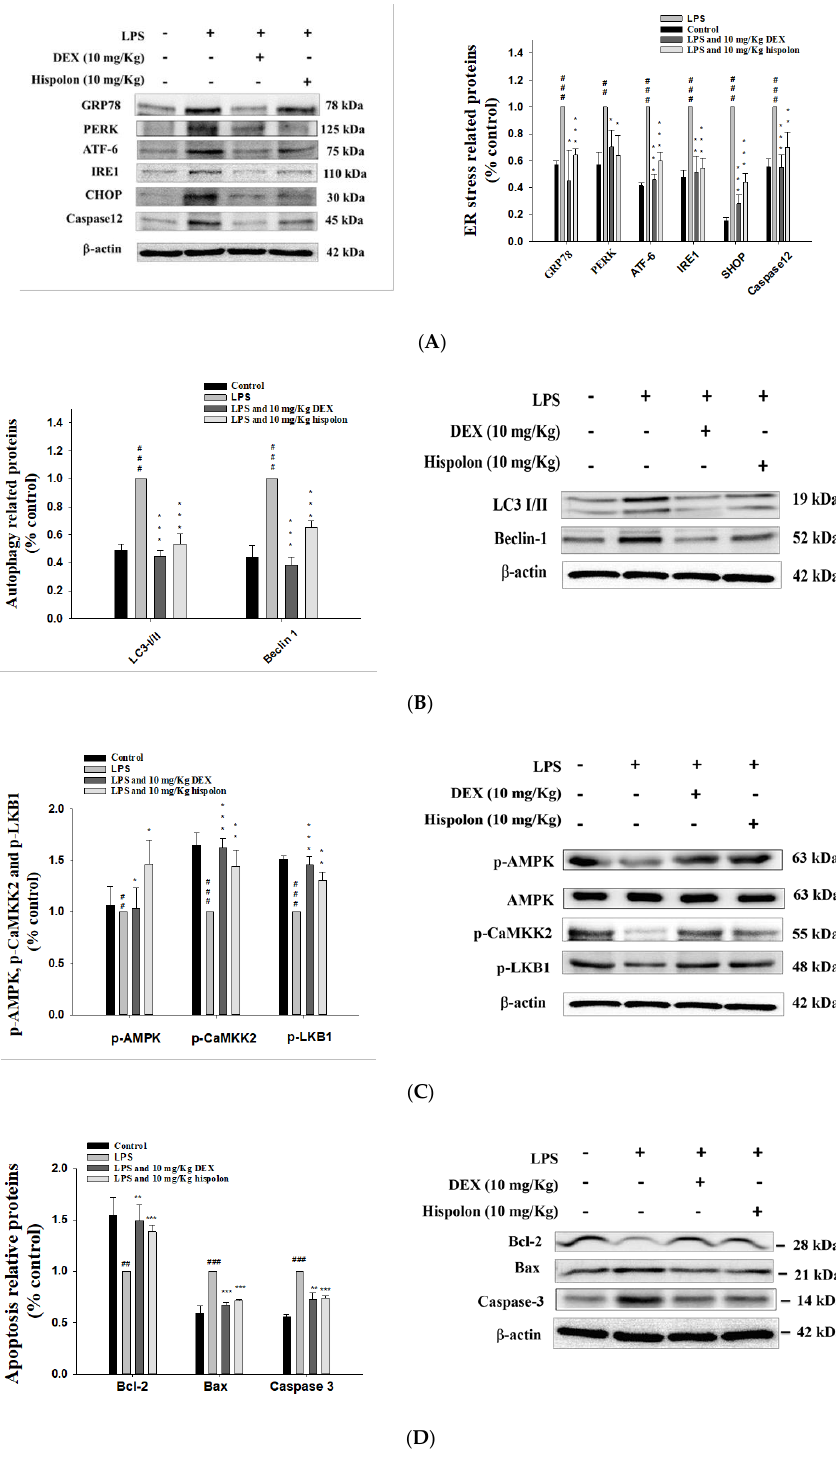
Figure 6. Effects of hispolon on ( A ) ER stress relative enzymes (PERK, IRE1 ATF6, GRP94, CHOP and caspase-12), ( B ) autophagy related enzymes (LC3-II/I and Beclin 1), ( C ) LKB1/CaMKK – AMPK signaling, and ( D ) apoptosis-related protein (Bcl-2, Bax and caspase-3) levels in the lungs of LPS challenge ALI. Lung tissue extracts were subjected to Western blot analysis using antibodies for PERK, IRE1 ATF6, GRP94, CHOP, caspase-12, LC3-II/I, Beclin 1, LKB1, CaMKK, AMPK, Bcl-2, Bax and caspase-3. Data are represented as means ± S.E.M. (n = 3). ## p < 0.01 and ### p < 0.001 versus the control group. * p < 0.05, ** p < 0.01 and *** p < 0.001 versus the LPS group.